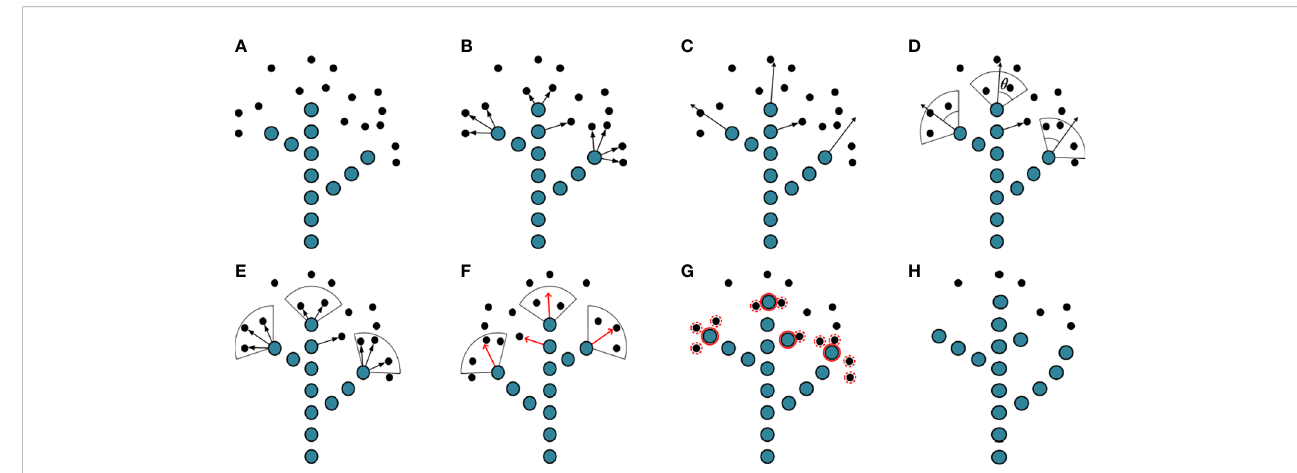
FIGURE 4 Illustration of space colonization algorithm. (A) Skeleton points and space points. (B) Connect the skeleton point with its space points. (C) Estimate neighborhood directions. (D) Calculate growth neighborhood. (E) Connect space points within growth neighborhoods. (F) Calculating growth vectors. (G) Generate new skeleton points and delete space points. (H) Complete an